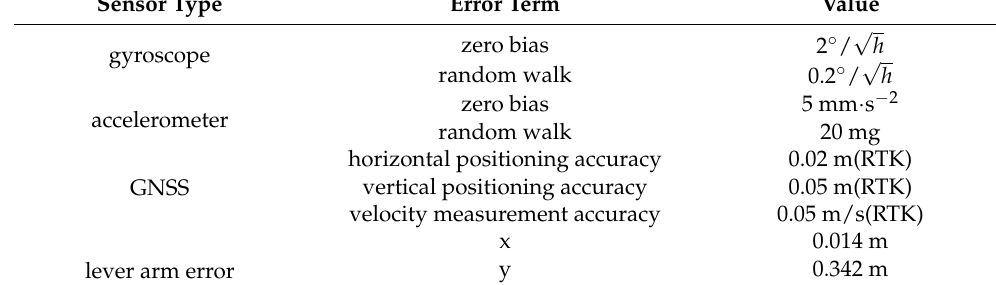
Figure 8. Trajectories of the experiments: ( a ) on land; ( b ) offshore.